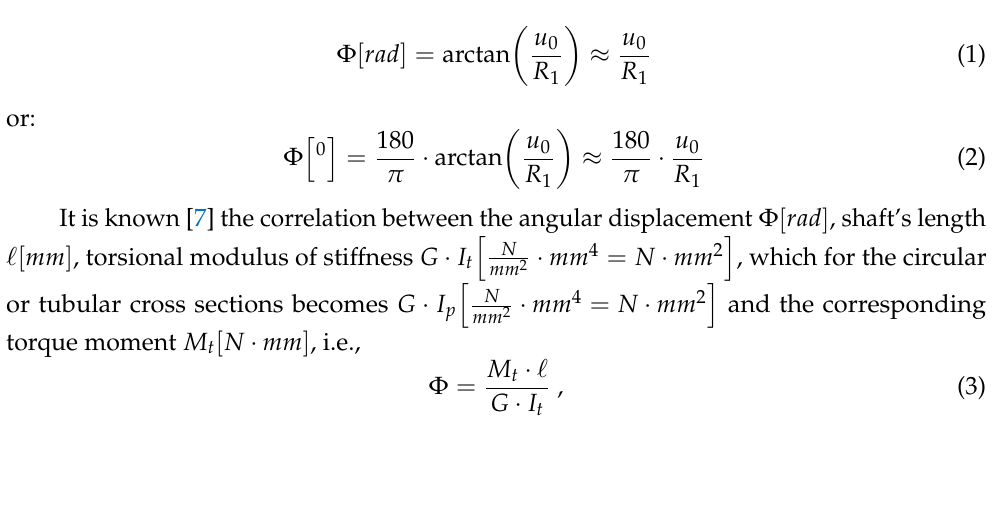
their amplitudes up to 0 516.0 . P , the corresponding 0